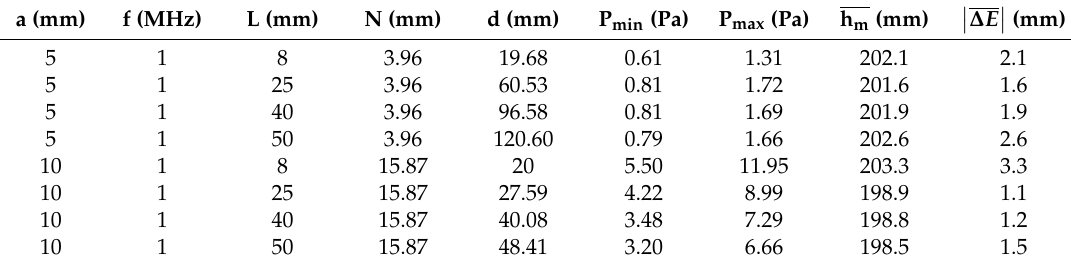
Table 2. Experimental results.